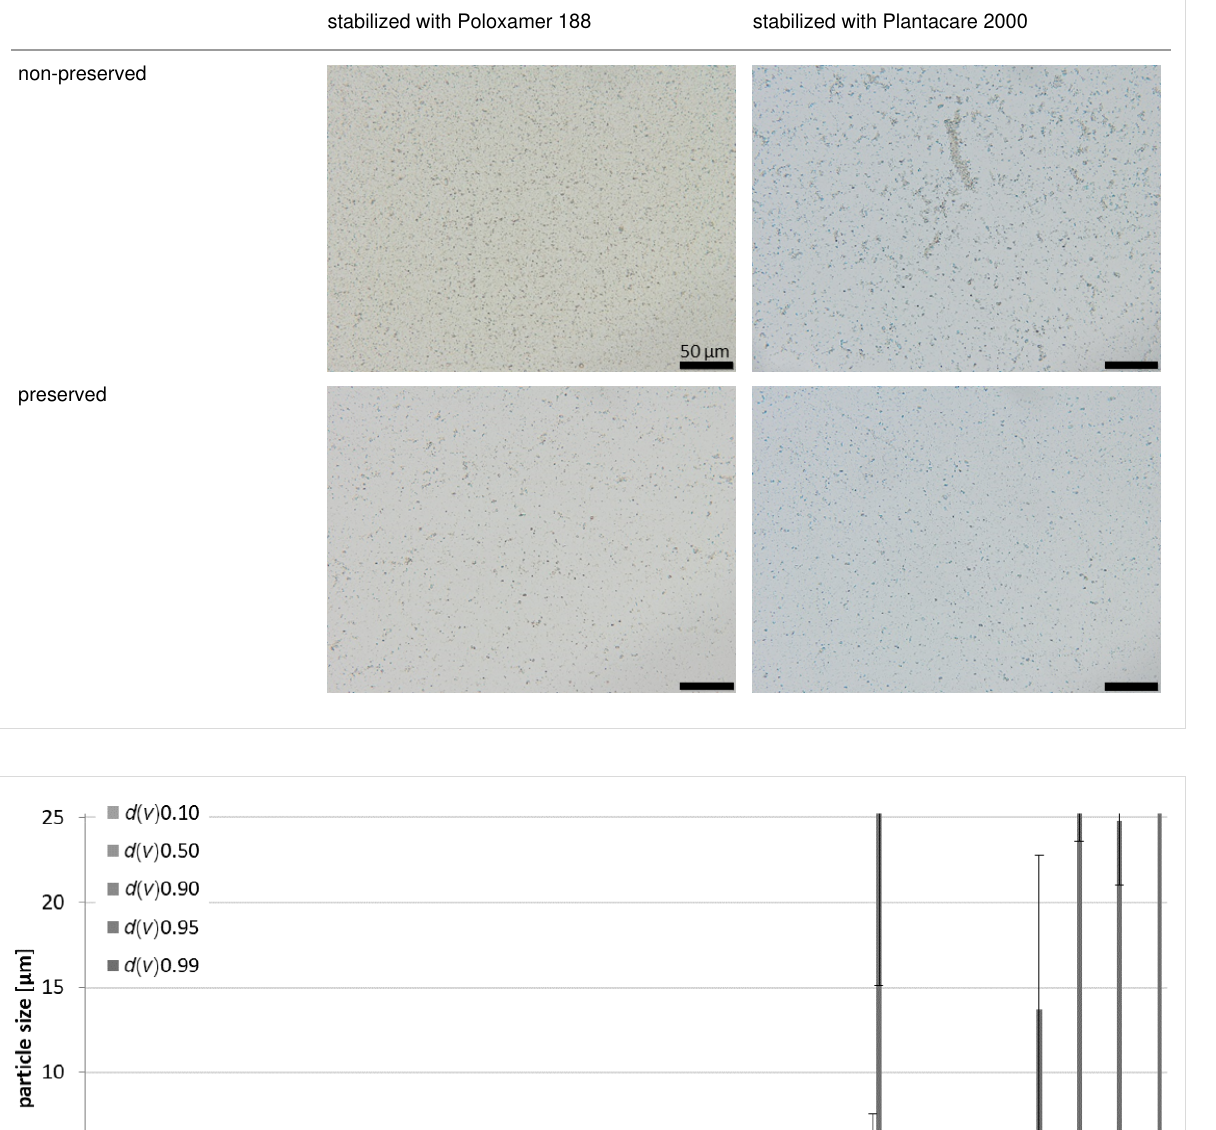
Table 2: Microscopic images of the nanosuspensions stabilized with Poloxamer 188 (left) and Plantacare 2000 (right) at the day of production. Magni- fication: 400-fold.